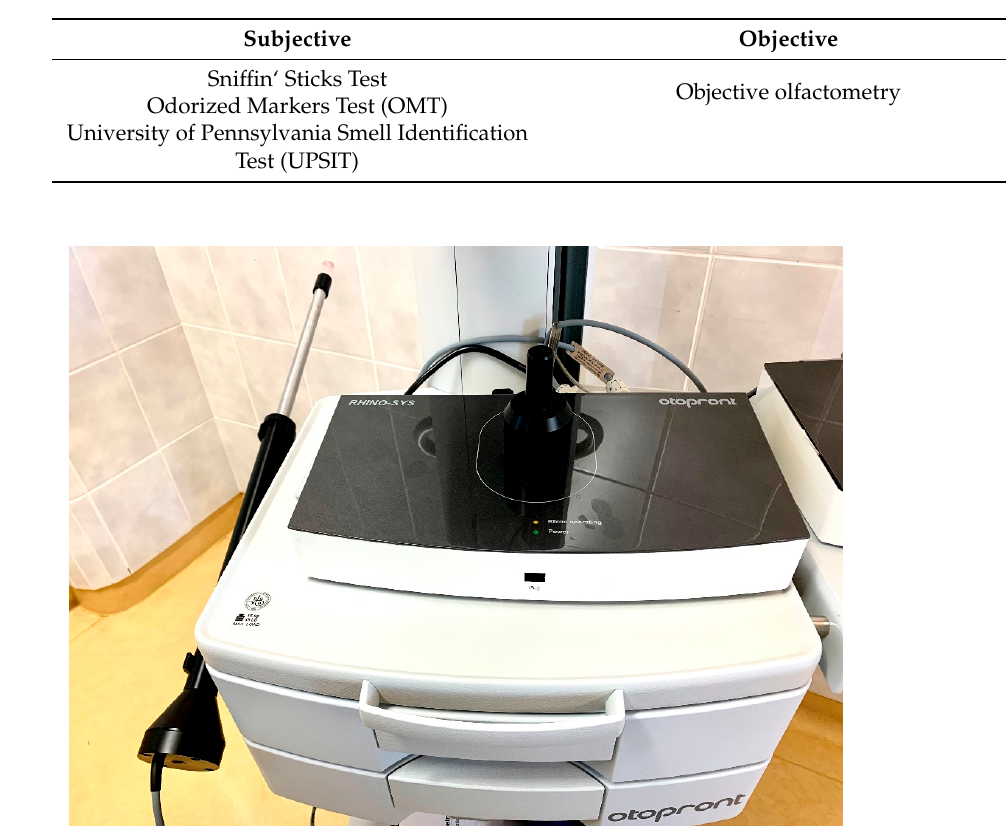
Table 3. Olfactory assessment methods.